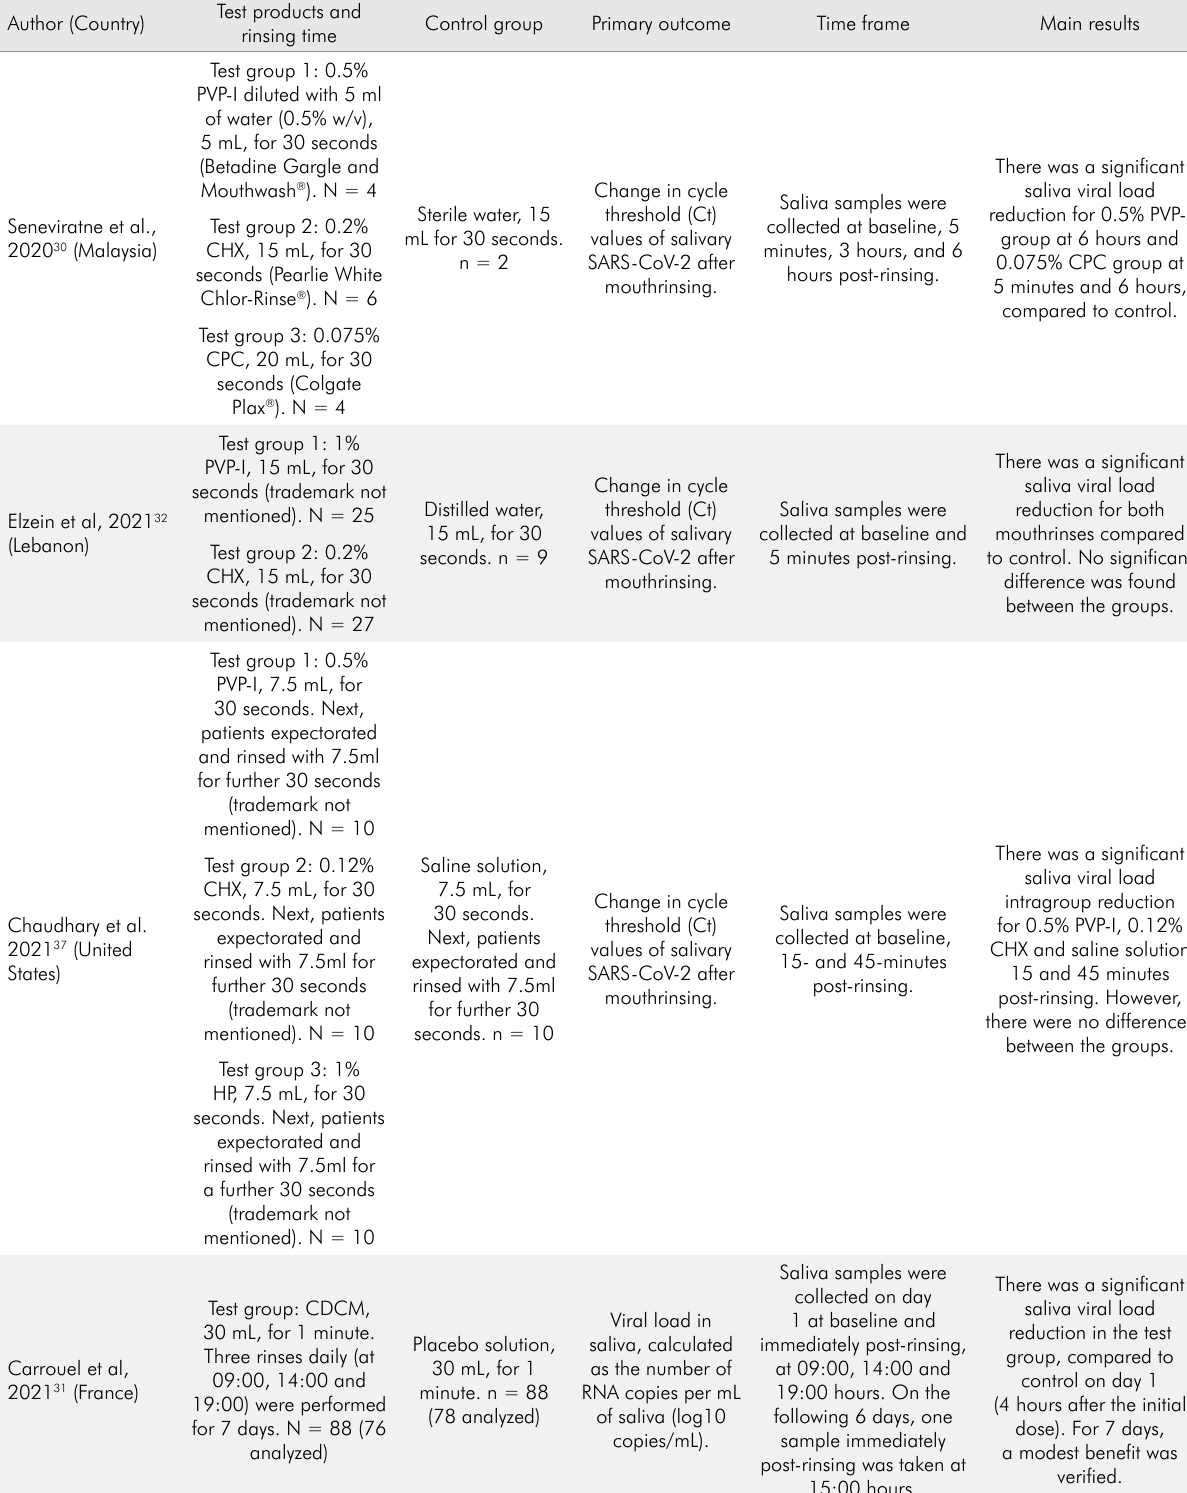
Table. General characteristics of randomized controlled trials that verified the efficacy of mouthrinses in reducing the salivary viral load of